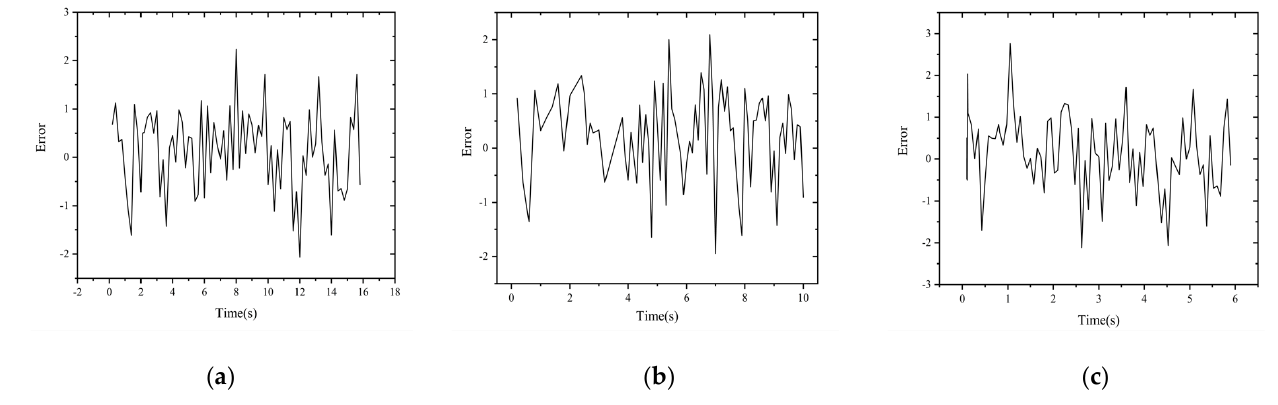
Figure 18. Depth− error chart. ( a ) 20 mm/s. ( b ) 40 mm/s. ( c ) 60 mm/s. Figure 18. Depth − error chart. ( a ) 20 mm/s. ( b ) 40 mm/s. ( c ) 60 mm/s.